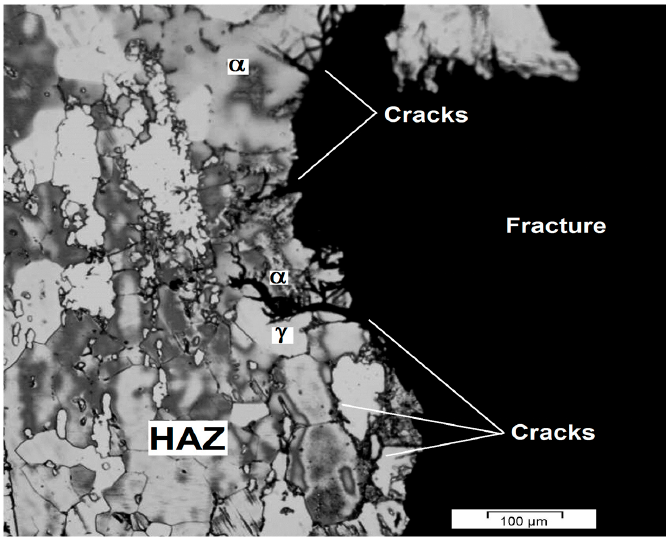
Figure 6. Transverse section of the fracture area in 2304 HAZ. Note cracks in the austenite/ferrite interface and in the ferrite phase.